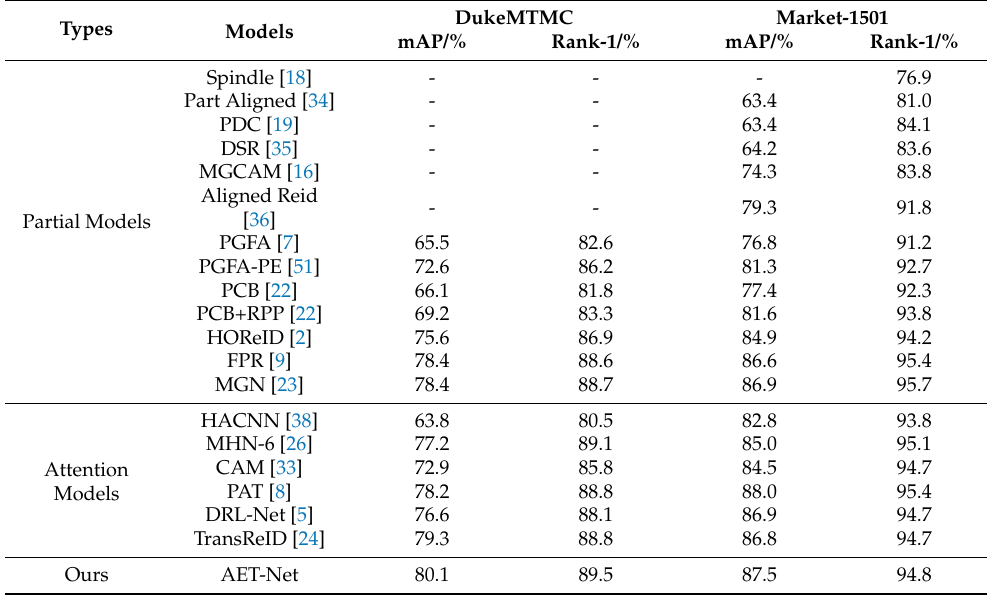
Table 2. The performance comparison between our proposed model and state-of-the-art models on DukeMTMC and Market-1501.